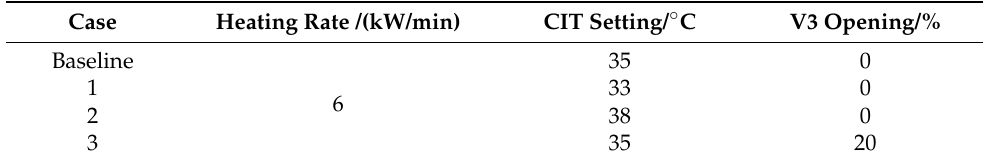
Figure 10. Comparison of various control temperatures and valve openings: ( a ) buffer tank density comparison; ( b ) buffer tank pressure comparison. Table 9. Parameters of different cases in phase 2.